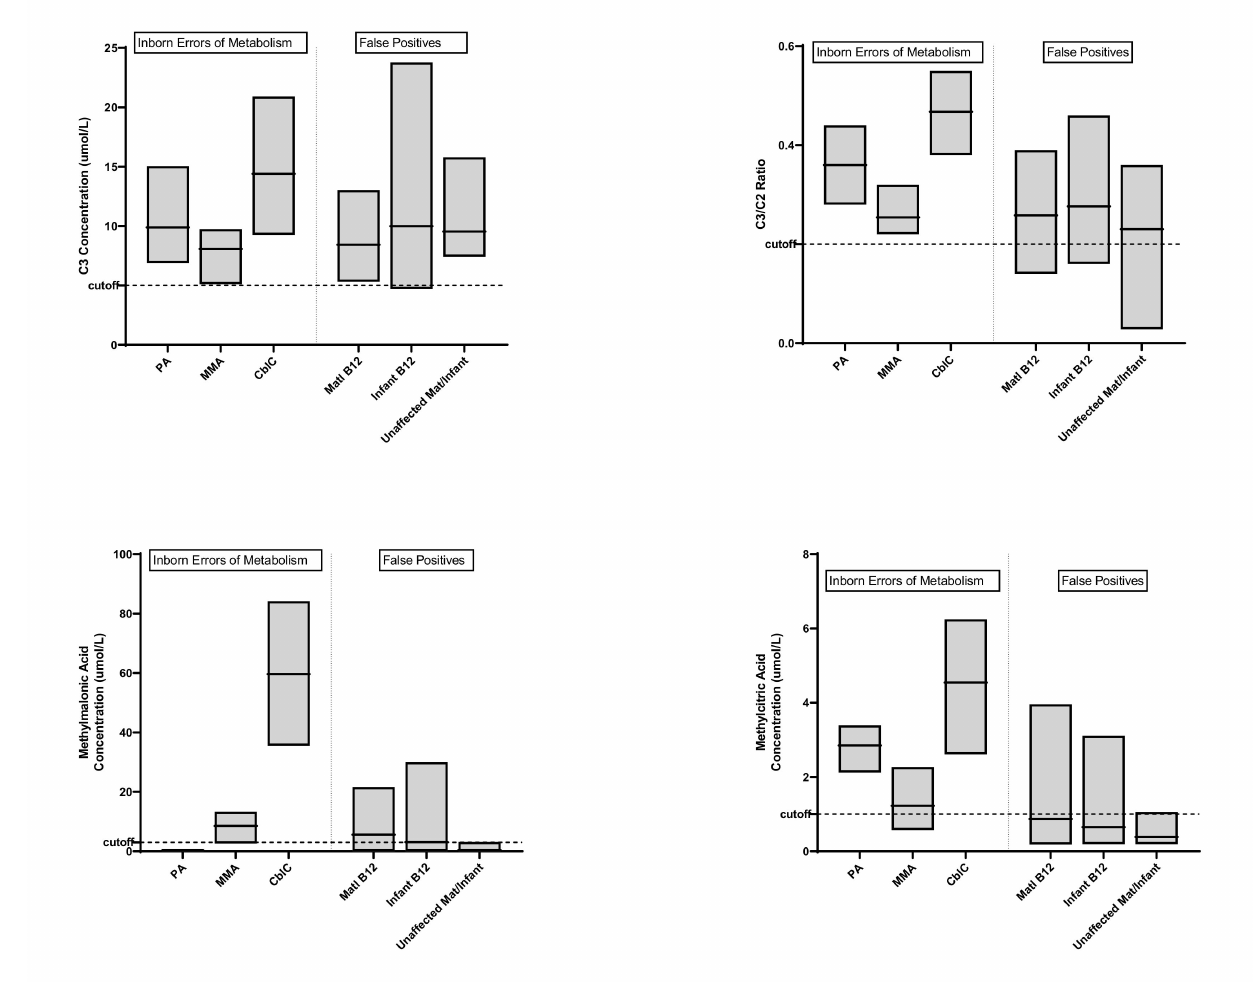
Figure 2. Concentration of disease markers propionylcarnitine (C3), propionylcarnitine to acetylcar- nitine ratio (C3/C2), methylmalonic acid, and methylcitric acid in positive C3 newborn screens in Wisconsin from 2013 to 2019. Cases are categorized by final diagnosis of inborn error of metabolism (propionic acidemia (PA), methylmalonic acidemia (MMA), or cobalamin C disease (CblC)) or false positive (maternal vitamin B12 deficiency [matl B12], infant vitamin B12 deficiency, or no evidence for vitamin B12 deficiency (unaffected